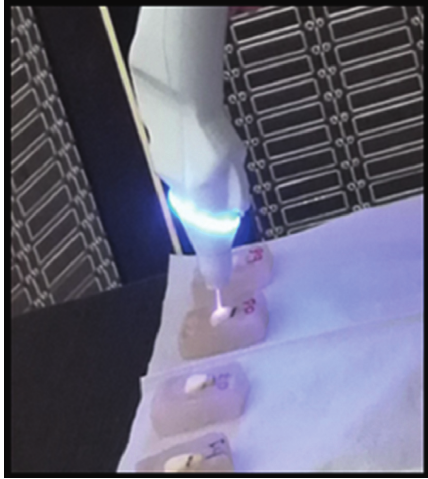
Figure 1: Application of CAP on the